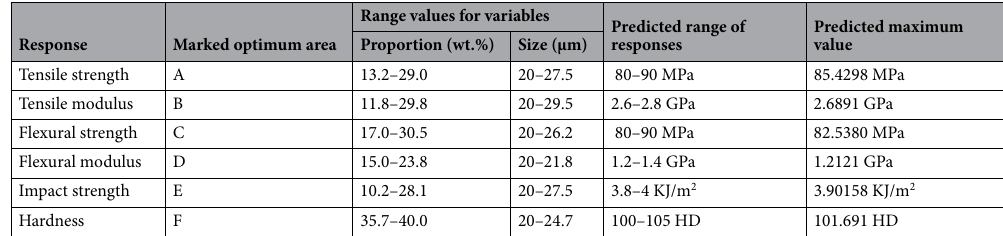
Table 9. The parametric combination of the variables in attaining optimized response parameters.